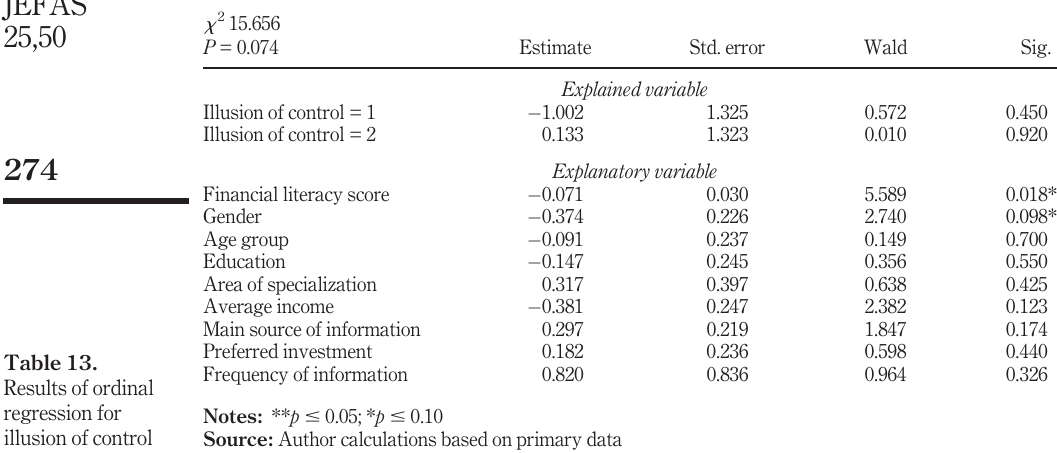
Table 13. Results of ordinal regression for illusion of control